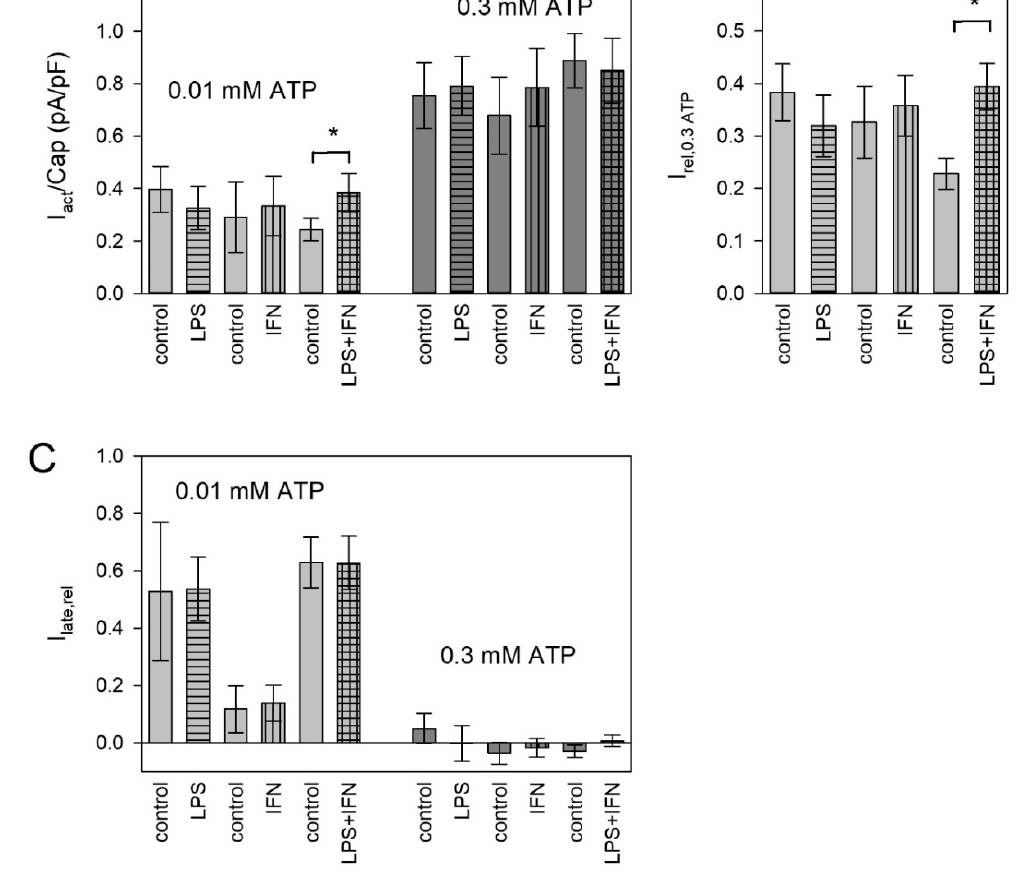
Figure 6. Effect of pro-inflammatory mediators on ATP-induced currents. 10 ng/mL lipopolysaccharide (LPS) and/or interferon gamma (IFN- γ ) were applied to the cell culture